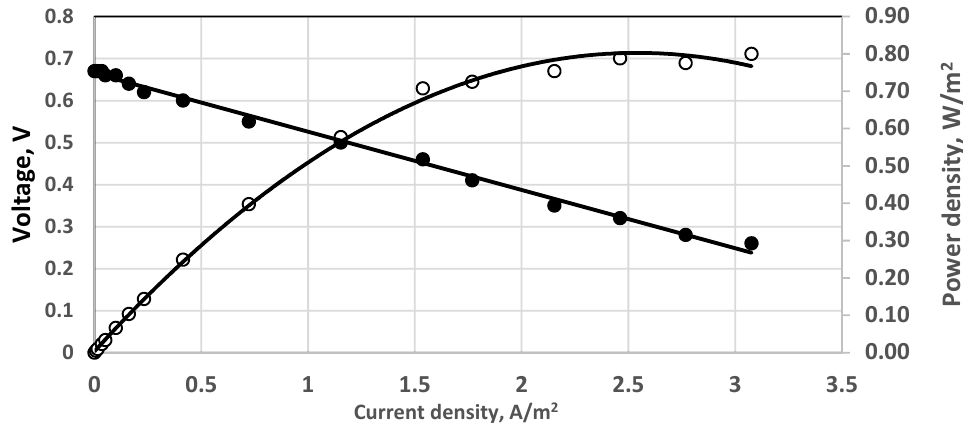
Figure 10. Polarization curve. Membrane Celgard 3501. Single fuel cell. Direct aeration, 0.5 dm 3 /h. Active electrode and membrane area—650 cm 2 . Feed flow rate—0.4 dm 3 /h. Anode volume 800 cm 3 . (•)—cell voltage; ( ○ ) power density; 230 mg dm − 3 sulfide solution. Temperature 20 °C.